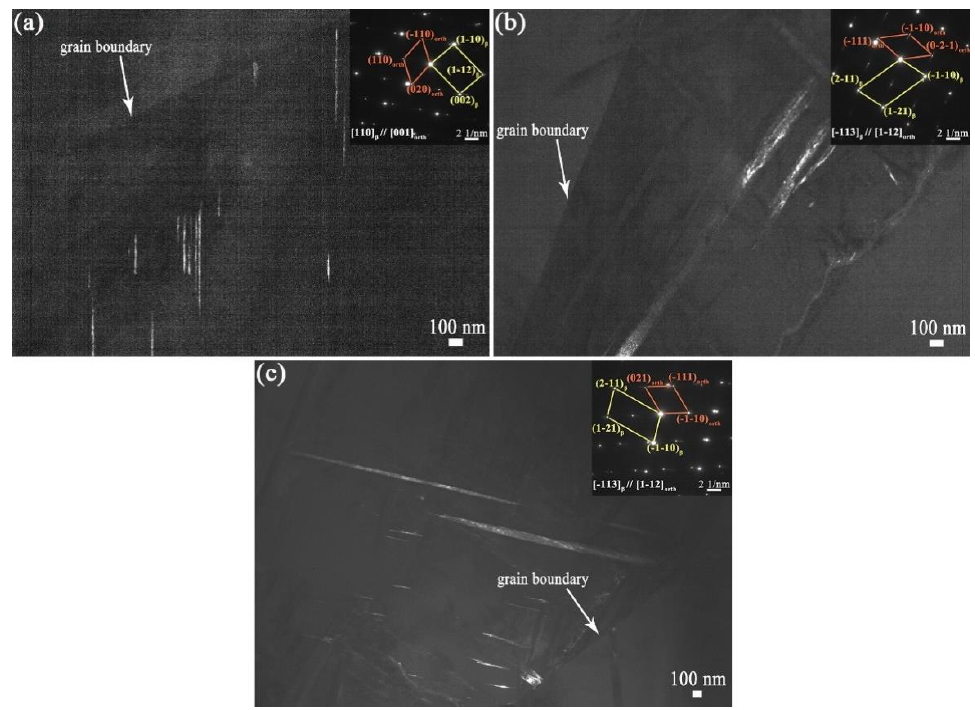
Figure 10. Dark-Field TEM image and Selected-Area Diffraction image of Position 2 ( a ), Position 3 ( b ), Position 4 ( c ) shown in Figure 2b.